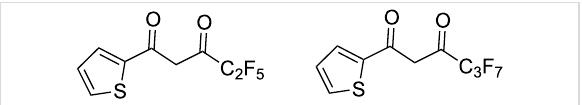
During the ongoing project, we needed to synthesize a family of 2-thienyl diketones with various lengths of a perfluorinated side chain. Here we intend to report a versatile and robust practical method for the preparation of new β -diketones bearing 2-thienyl and various linear perflu о rinated (C 2 –C 8 ) substituents. The method is also suitable for synthesizing 1-(2-thienyl)butane-1,3- dione and its